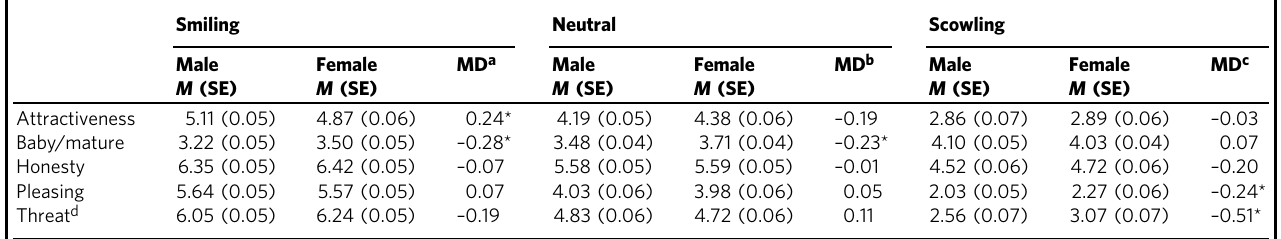
Table 4 Facial expression x gender, social perception questions ( M , SE, mean difference).